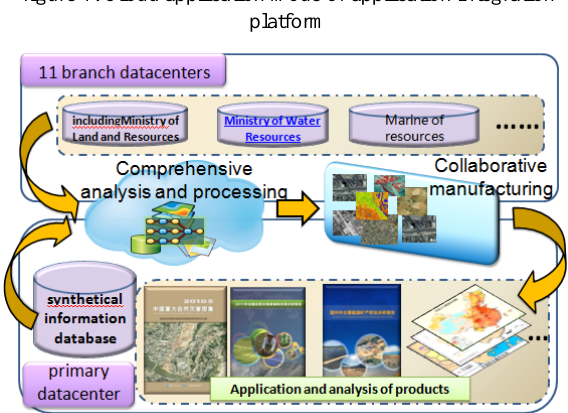
figure 2. multi-sector collaborative analyzed synthetical